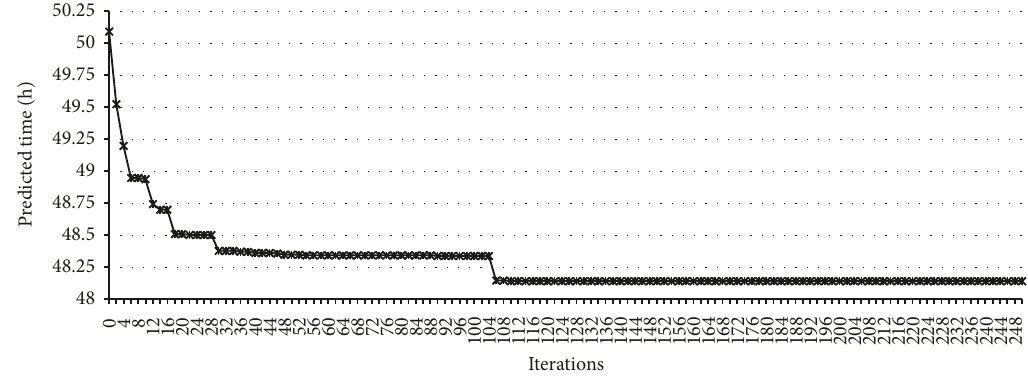
Figure 10: Probability of unit length on each edge.